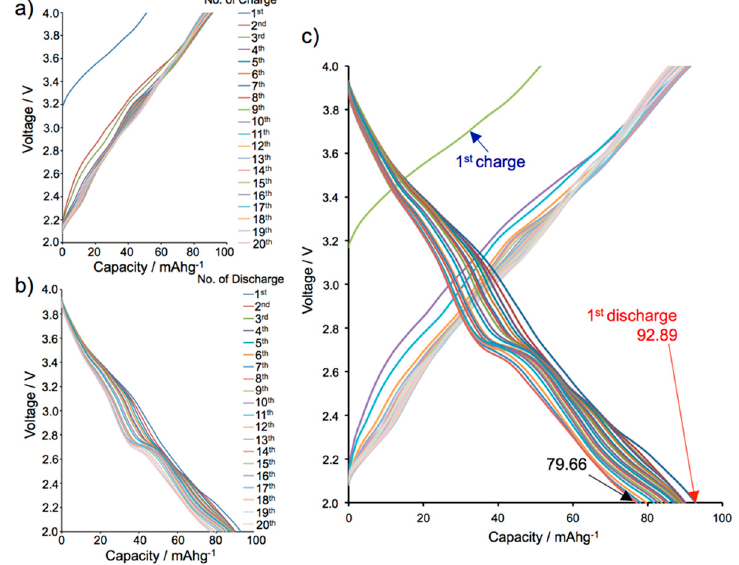
Figure 4. Charge/discharge performances of Li-[28]hex battery: range = 2~4 V, number of cycles = 20, and operation current = 0.2 mA. ( a ), ( b ), and ( c ) show charge performances, discharge performances, and overall charge and discharge performances.